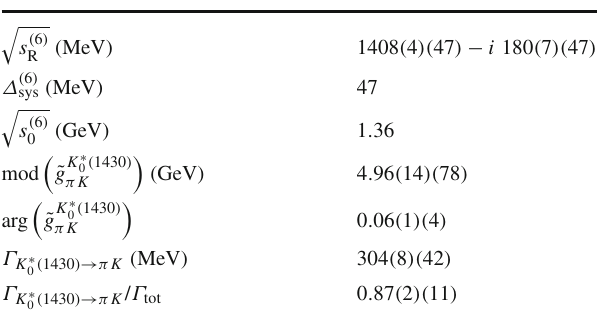
Table 5 Results of Padé extractions at N = 6 for the K ∗ including statistical (first bracket) and systematic uncertainties (second bracket)